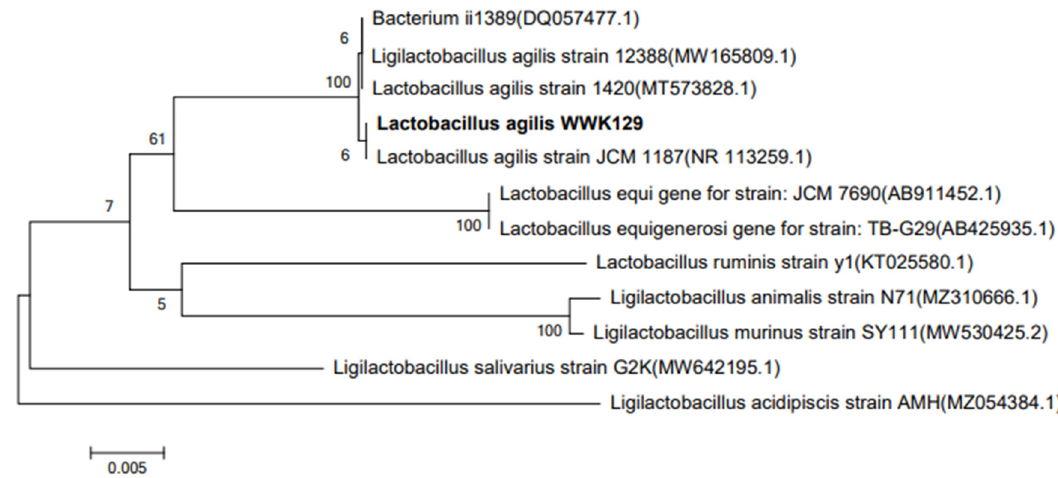
Figure 4. Phylogenetic tree based on 16S rDNA sequence of gossypol-degradation strain L. agilis WWK129.